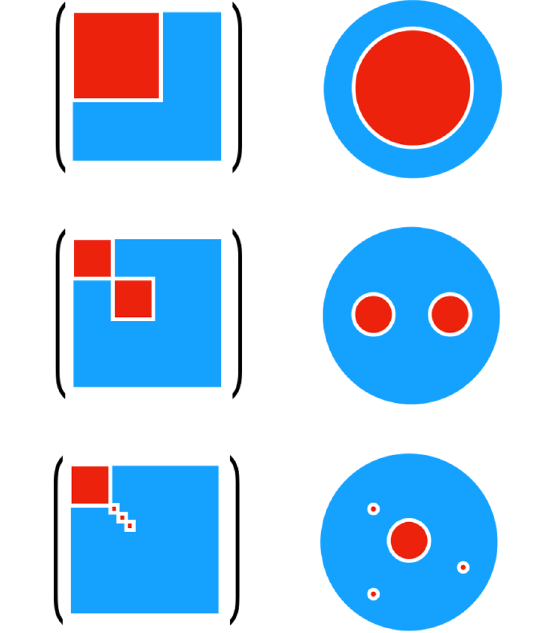
Figure 22. [Top] Partially deconfined phase should correspond to the small black hole in the bulk. [Middle] A state with two partially-deconfined sectors would describe two small black holes. [Bottom] Radiation from black hole would be described by small